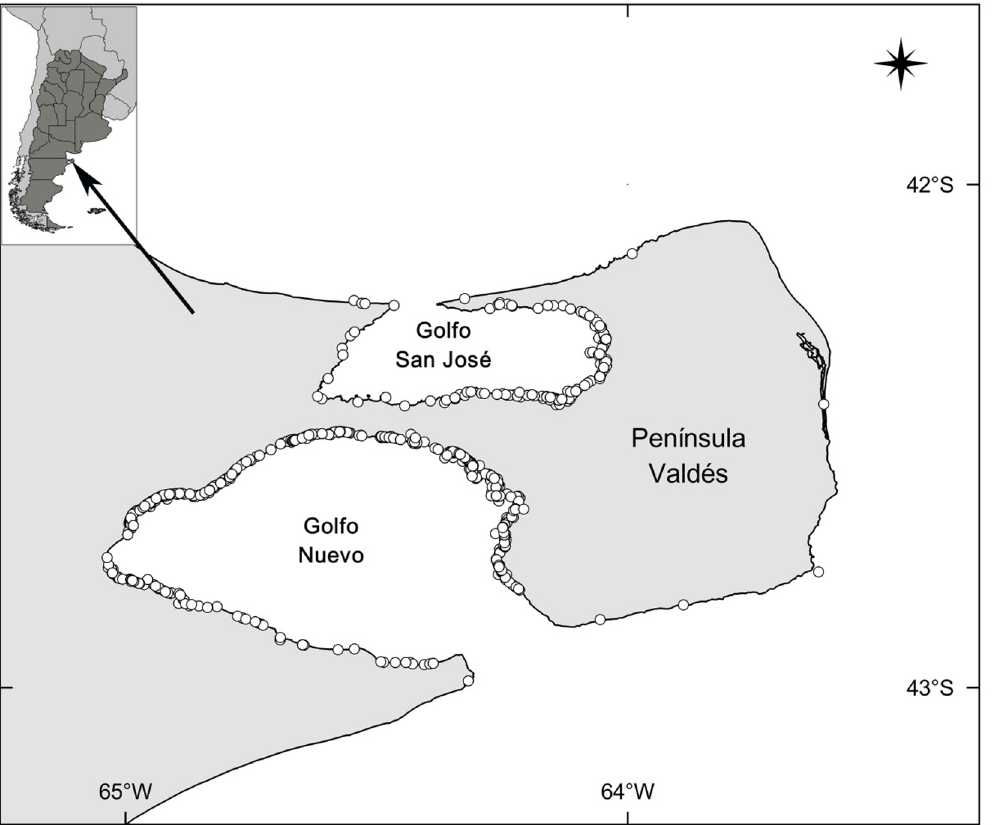
Fig 1. Locations of dead calves at Península Valdés, Argentina. White circles represent the locations of 626 dead calves that were found at Valdés in the period 2003 –